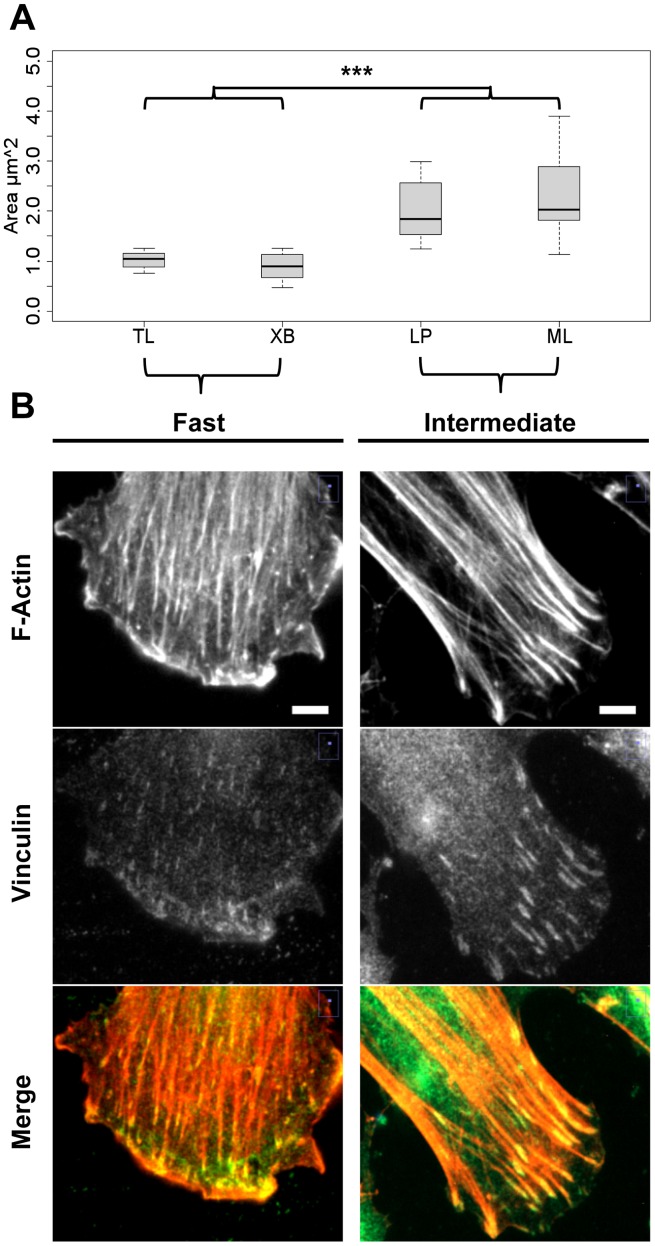
Size of focal adhesions differs between the two CLP migratory groups.Immunofluorescence staining against vinculin, and rhodamine-phalloidin staining for F-actin of migrating cells 24 h after scratch wounds were applied. Two randomly chosen strains from the “fast” (TL and XB) and the “intermediate” (LP and ML) group, respectively, were included in the analysis. (A) The box plots indicate the area in µm2 covered by individual vinculin positive focal adhesions at the front end of cells (n[cells per strain] = 12–15). The whiskers indicate the maximum and minimum area per focal adhesion in a strain (***p<0.001). (B) Representative pictures from two strains depict the front end with the lamellipodium of individual cells migrating into the wound. Typically, migrating cells of the “fast” CLP group form smaller focal adhesions in comparison to cells of the “intermediate” group. Scale bar, 10 µm.